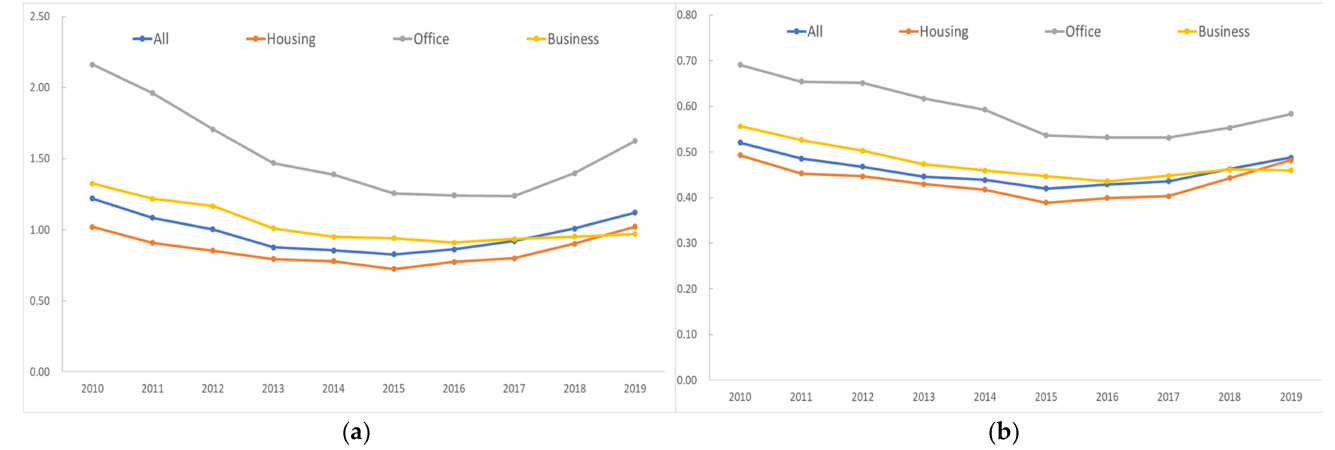
Figure 5. Analysis of the changing trend of CV and GI ( a ) Coefficient of variation; ( b ) Gini